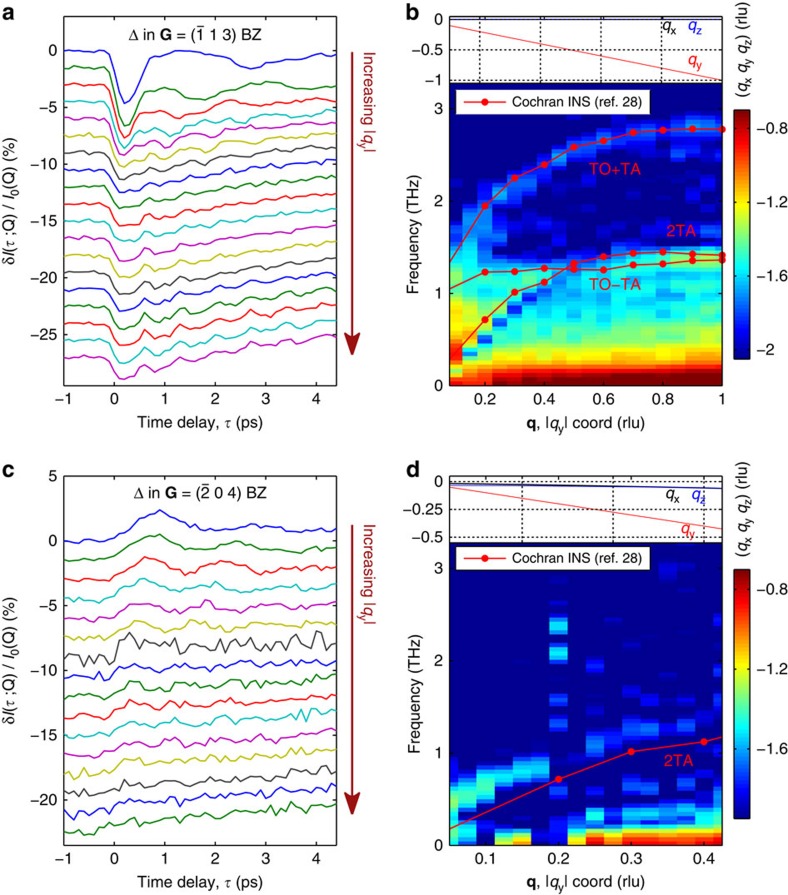
Fourier-transform inelastic X-ray scattering (FT-IXS) spectra for transverse two-phonon excitations along the bonding direction.(a,c) Time-domain differential X-ray diffuse scattering intensities at various q coordinates along the approximate Γ to X (Δ) high-symmetry reduced wavevector direction in both the (1 3) Brillouin zone (BZ) and the (0 4) BZ respectively. This direction is shown in both BZs in Fig. 1a. The observed modulations stem from temporal coherences in the momentum-dependent phonon-phonon correlations. (b,d) Simultaneous frequency and momentum representations of the time-domain data in a,c, respectively, on a base-10 logarithmic scale, with two-phonon dispersion calculated from the INS data of ref. 28 overlaid. The trajectories of the momentum coordinates are displayed above each spectrum in reciprocal lattice units (rlu). Note the deviation of the qx and qz coordinates from the nominal Δ wavevector coordinates in panel (d). Clear matches with first overtone and combination transverse polarized phonon states are seen. Note that broadband behaviour seen near |qy|∼0.2 in panel d is due to noisier statistics that arise from an average over a smaller solid angle, in comparison with data at other q coordinates.